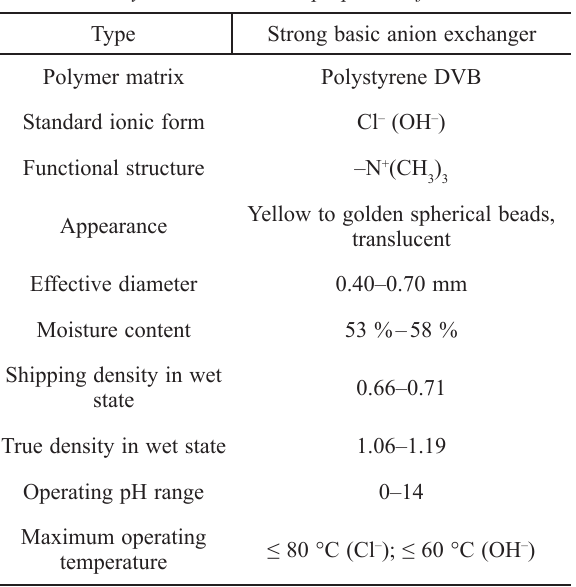
Table 1 – Physical and chemical properties of the 201×7 resin Type